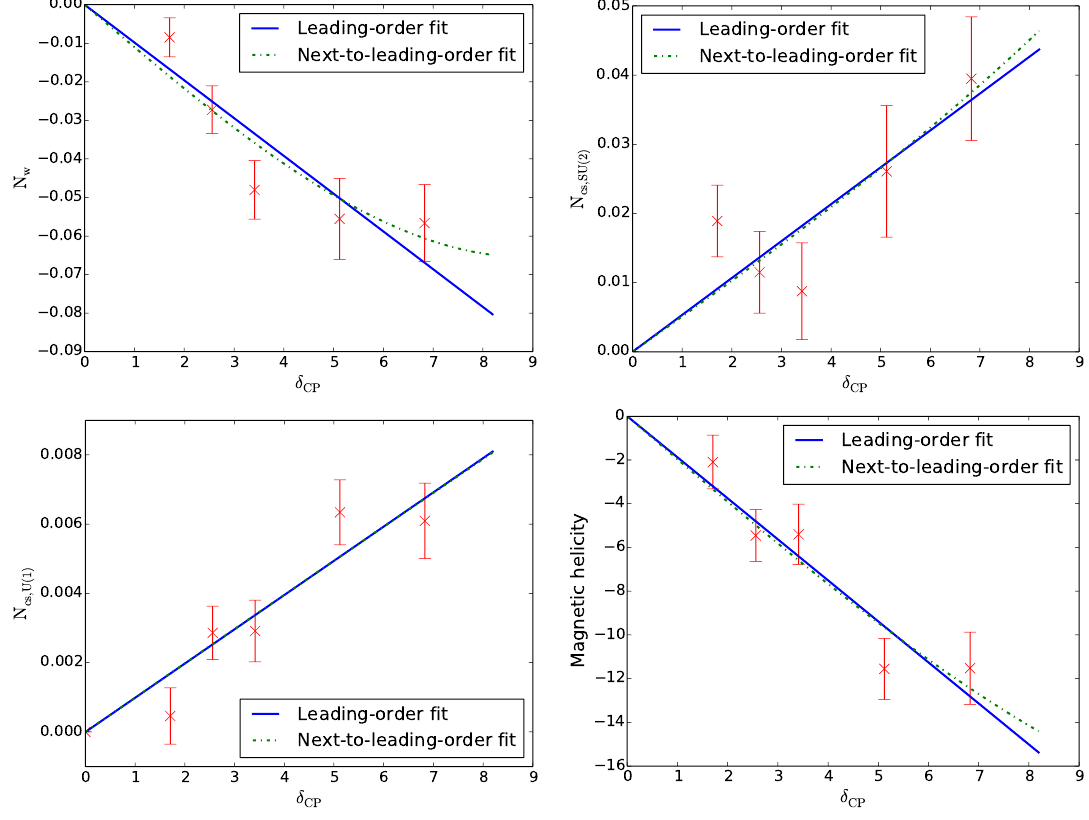
Figure 5 . The dependence of all the CP-odd observables on (cid:14) cp . Clockwise from top left: N w , N , Magnetic helicity, N cs ; SU(2) cs ; U(1)